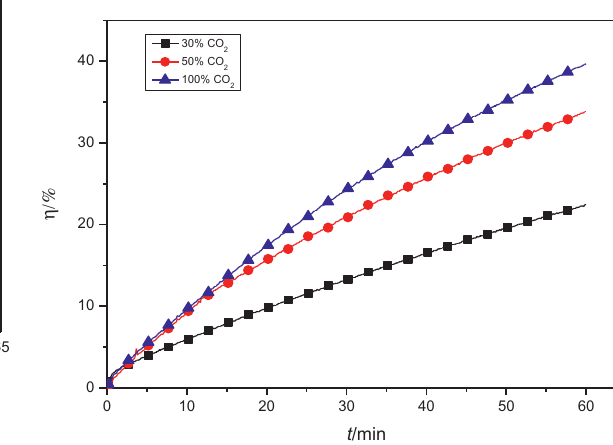
Figure 5: Weight loss of ferro-coke at various atmospheres.